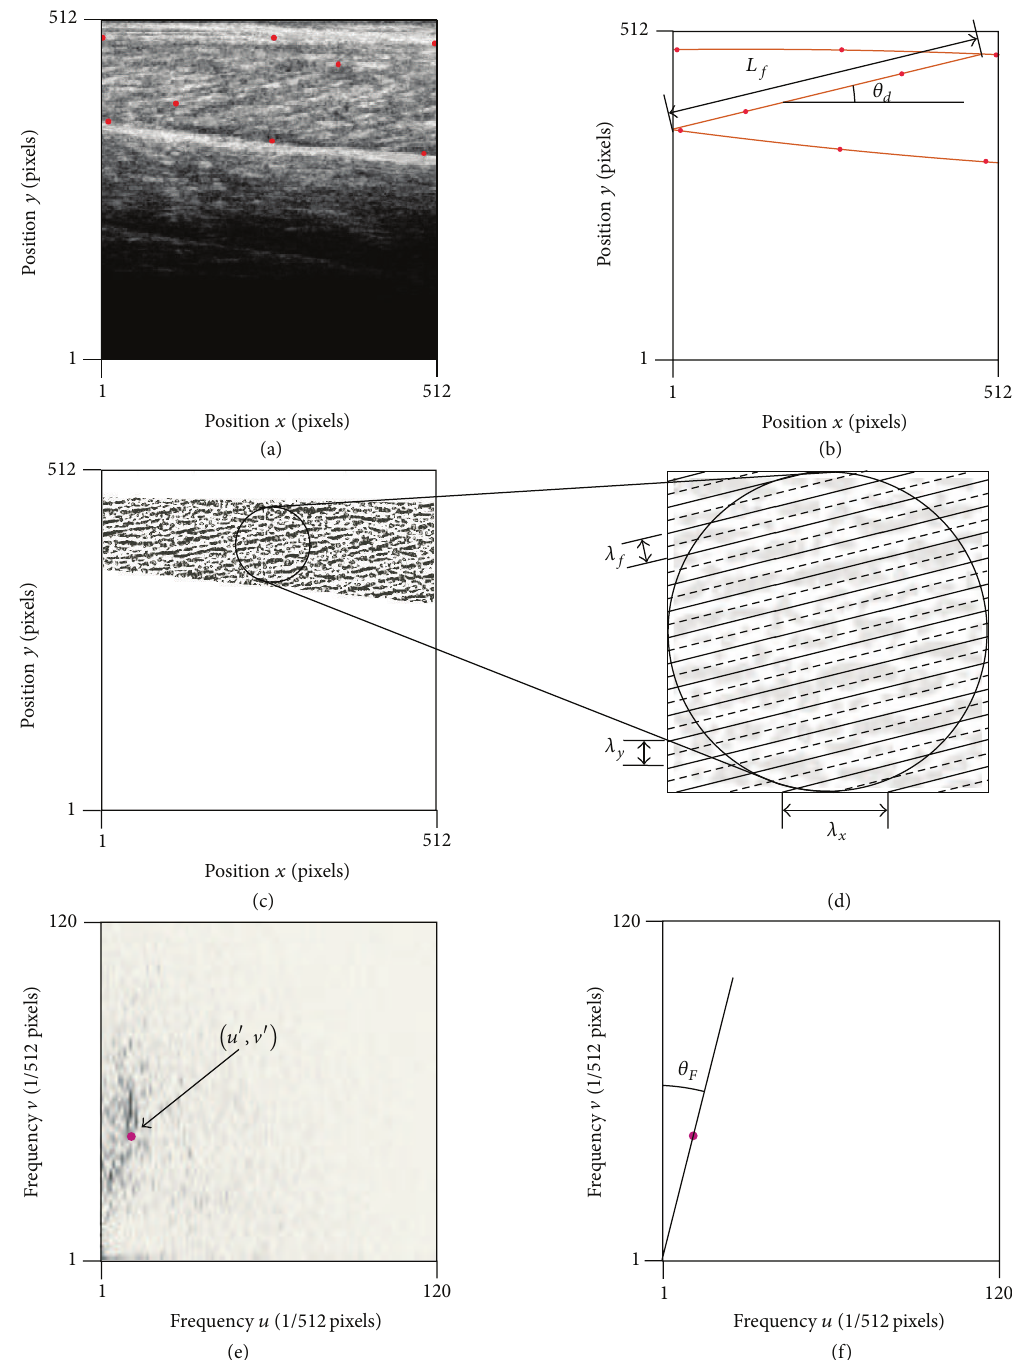
Figure 1: The Analysis Method . Coordinates on the superficial and deep aponeuroses and a representative fascicle were manually digitized (red points) for each ultrasound image (a) and used to calculate the fascicle length 𝐿 𝑓 and inclination angle 𝜃 𝑑 relative to the 𝑥 -axis (b). Fascicles were enhanced using multiscale vessel enhancement filters and the region of interest was determined between the aponeuroses (c). The repeating fascicular nature is described by its transverse wavelength 𝜆 𝑓 , which can be resolved into wavelengths 𝜆 𝑢 and 𝜆 V that are in the 𝑥 - and 𝑦 -directions, respectively (d). The spatial frequencies 𝑢 and V were determined using a discrete Fourier transform, and the major spatial frequencies characterized by the moment of frequency ( 𝑢 󸀠 , V 󸀠 ) (e). The inclination angle 𝜃 𝐹 was were determined from the major spatial frequencies (f), and the wavelengths 𝜆 𝑢 and 𝜆 V were calculated from these